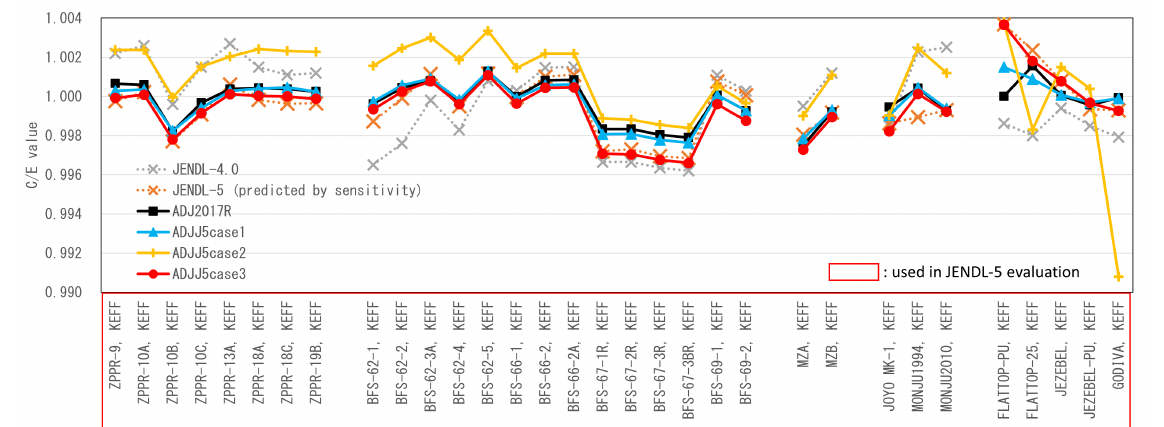
Figure 1. C / E values of criticality